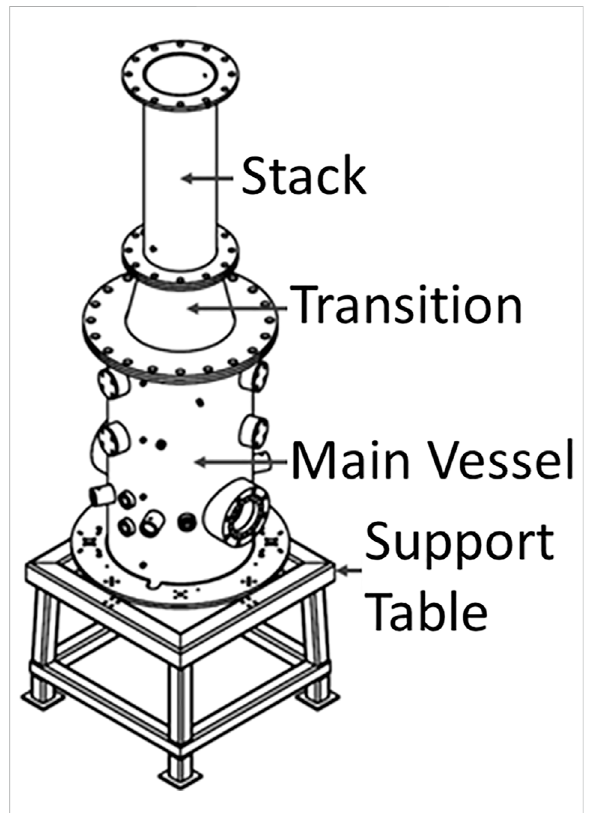
Customized test furnace for testing electric fi eld effects on combustion process (burner assembly not